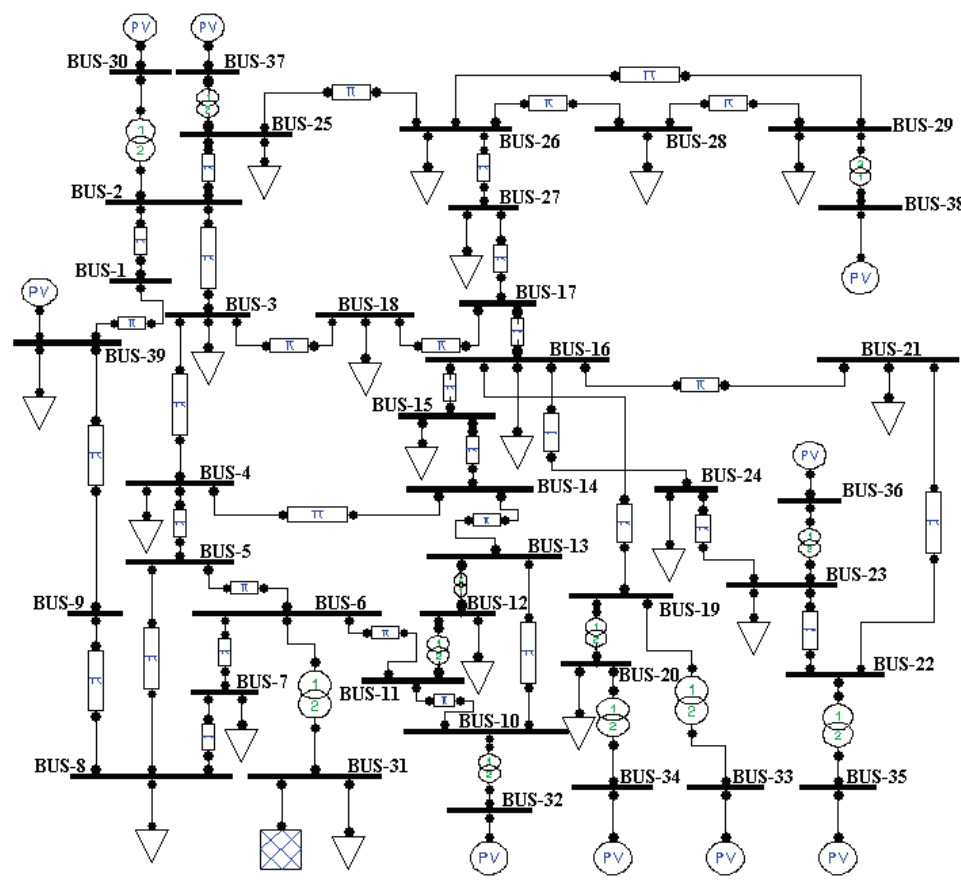
Figure 1. IEEE 39-BUS New England power